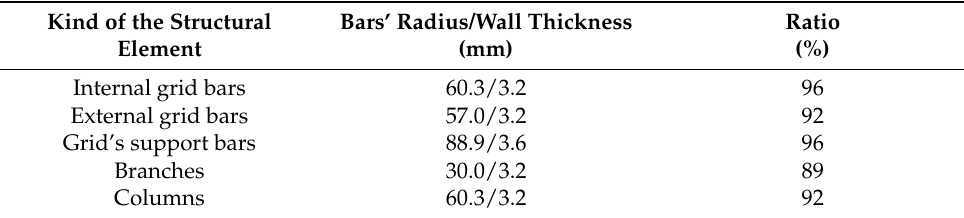
Table A2. Structural analysis results of structure 3a performed by Robot Structural Analysis Profes- sional